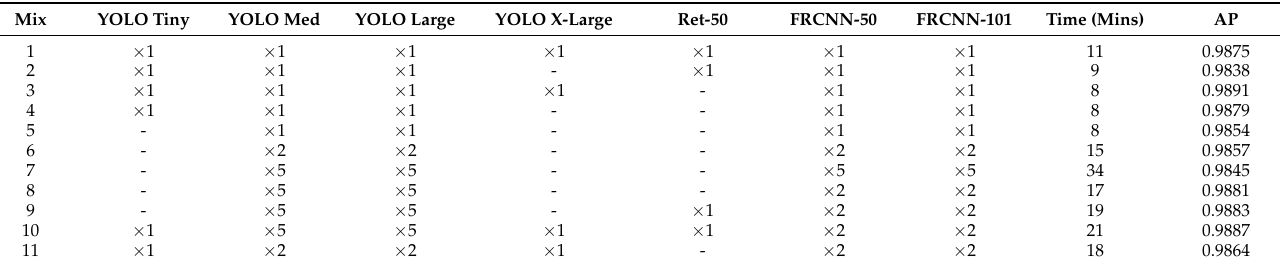
Table A5. Composition and AP values of mixed